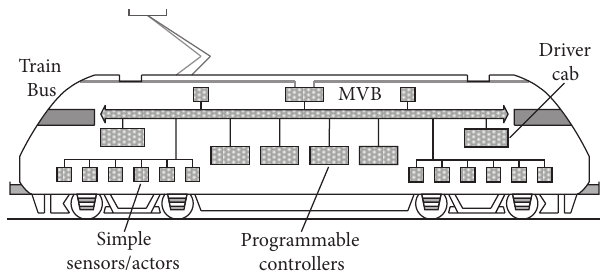
Figure 1: Multifunction Vehicle Bus in a